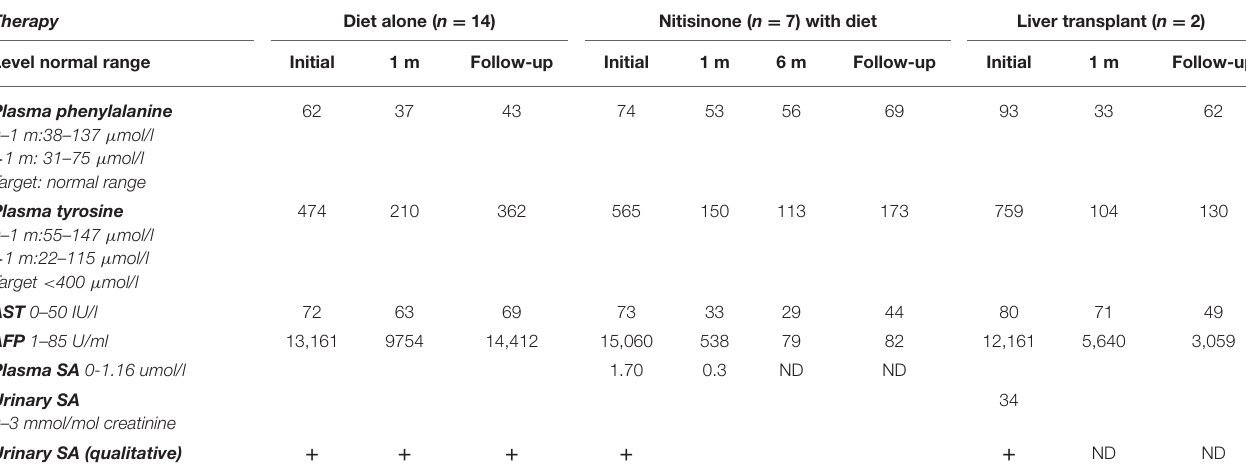
TABLE 2 | Biochemical liver profile in patients with hereditary tyrosinemia type 1: median levels at diagnosis and follow-up. Therapy Diet alone ( n = 14) Nitisinone ( n = 7) with diet Liver transplant ( n = 2) Level normal range Initial 1 m Follow-up Initial 1 m 6 m Follow-up Initial 1 m